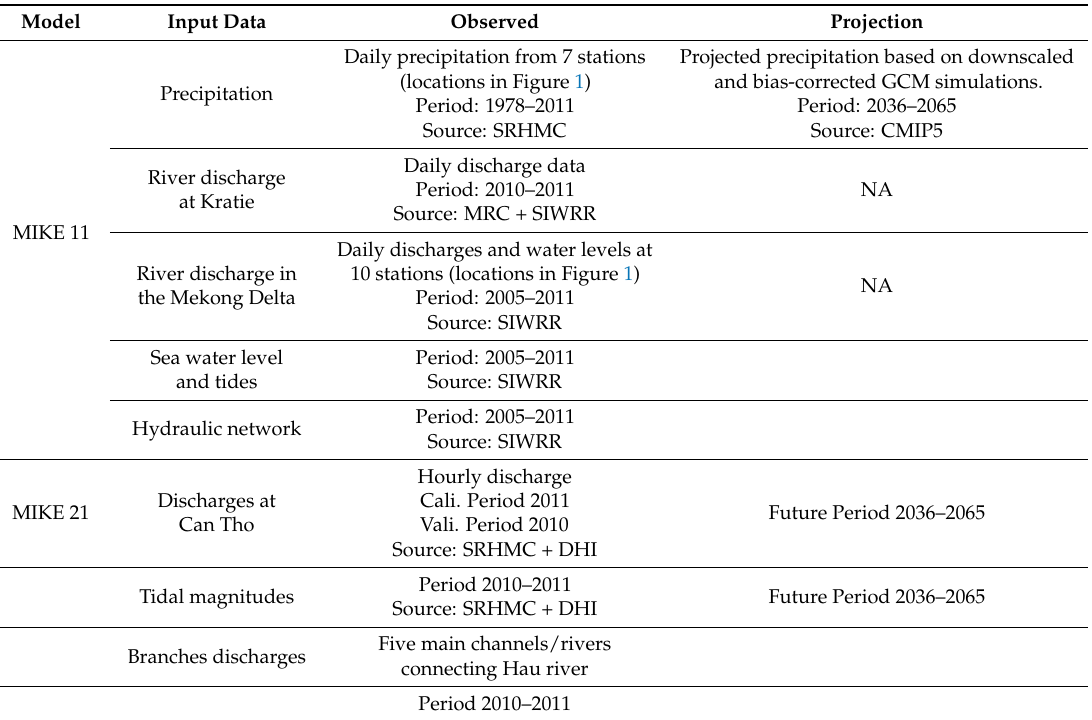
Table 1. Main input data for the model simulations.